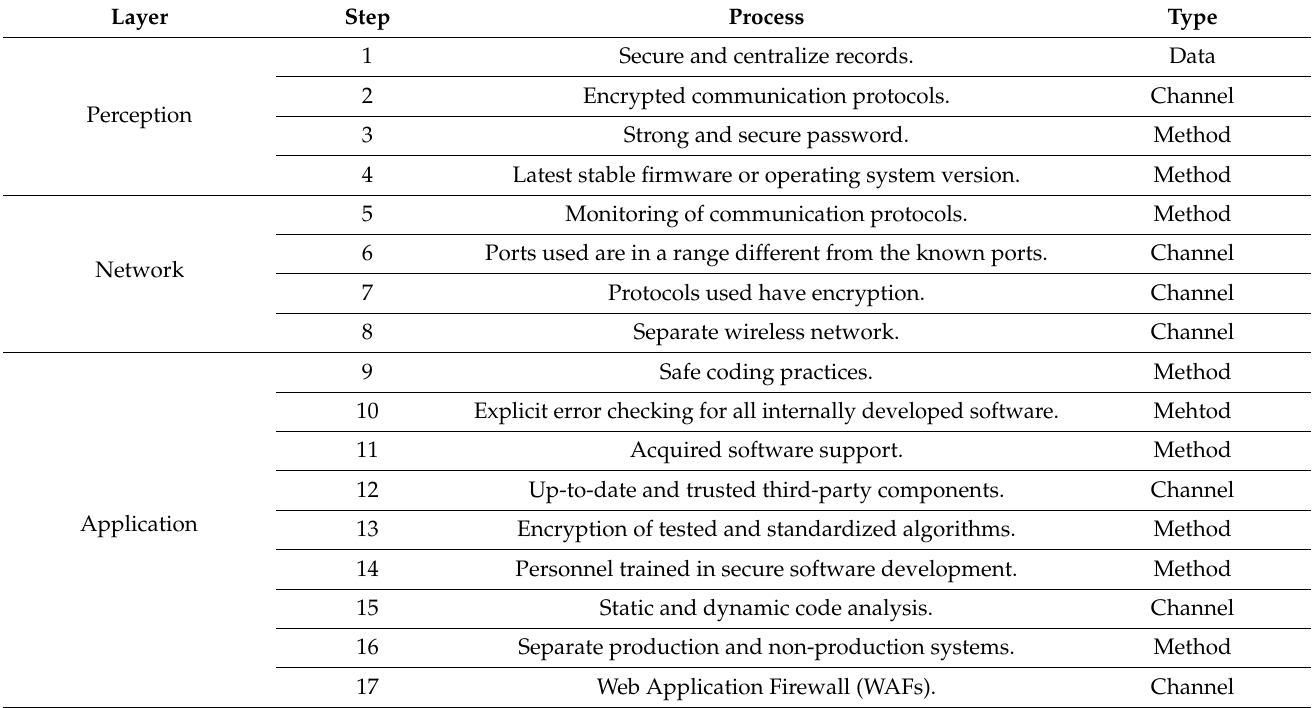
Table 8. IoT system elements